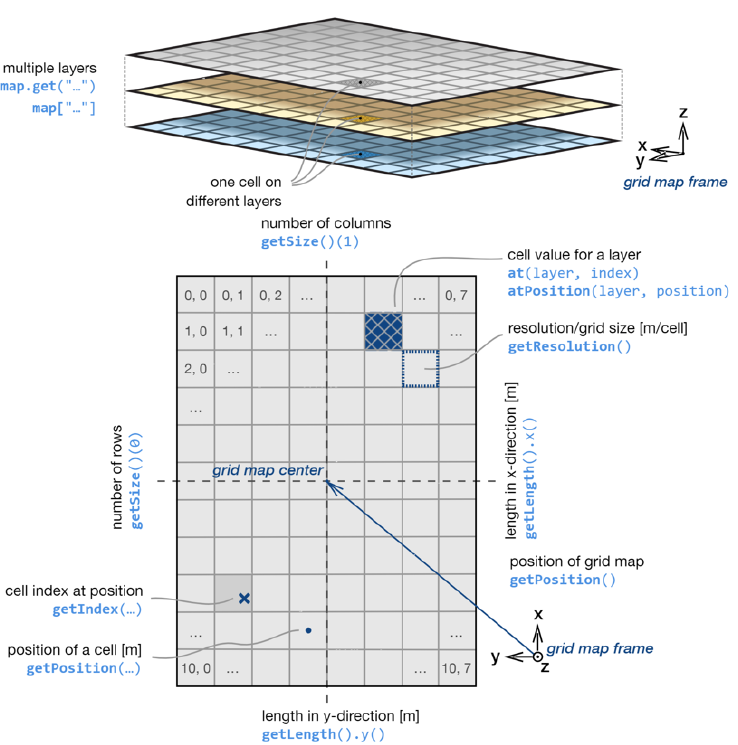
Figure 1. Structure of multi-layer grid map: multi-layer structure (upper part) and grid data structure of each layer (lower part).